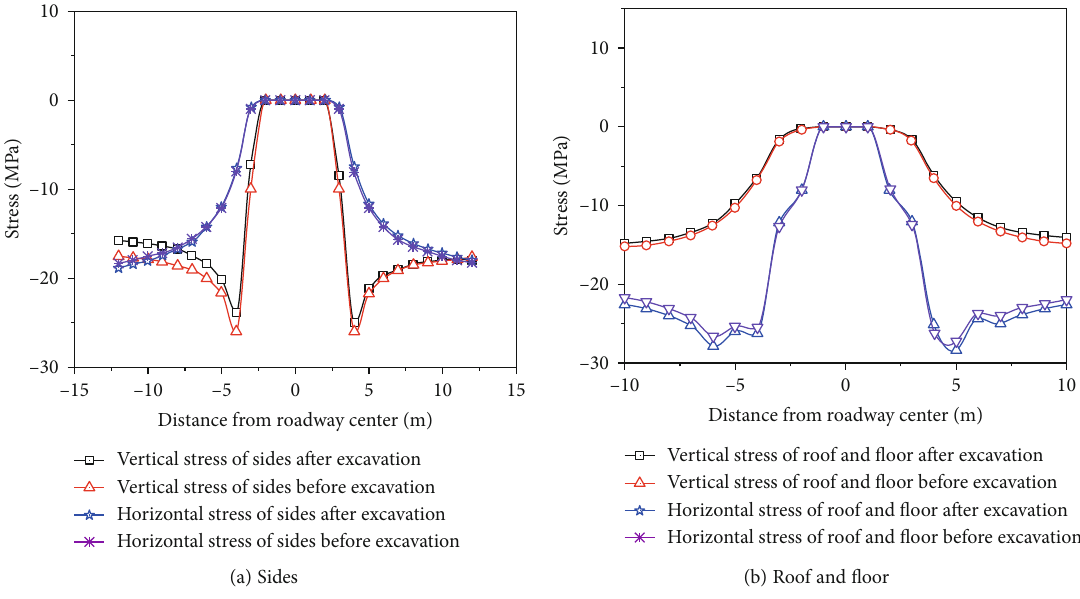
Figure 18: Stress distribution curve of roadway surrounding rock after stress and displacement distribution characteristics of the surrounding rock of the FGDR have no signi fi cant di ff erence, so we will not repeat it. Figure 16. Compared with the external staggered layout, the